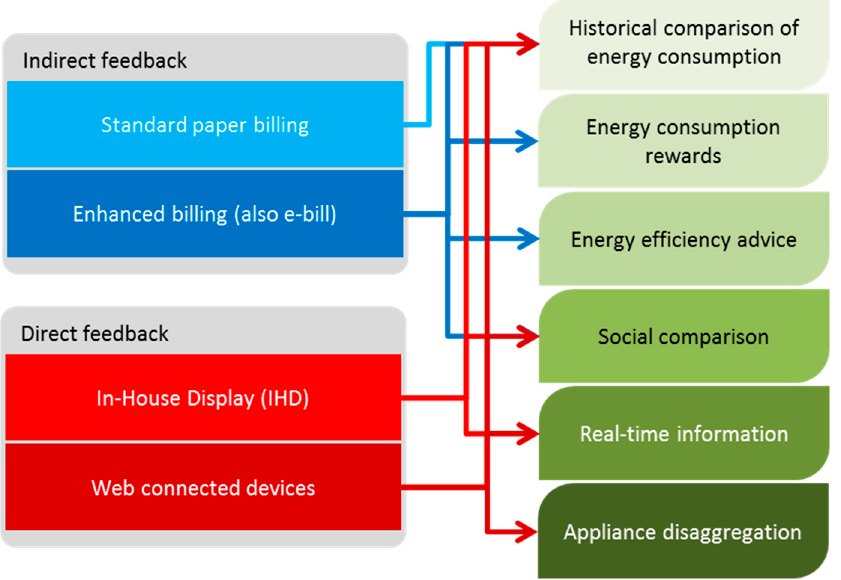
Figure 2. Types of feedback and information provided.